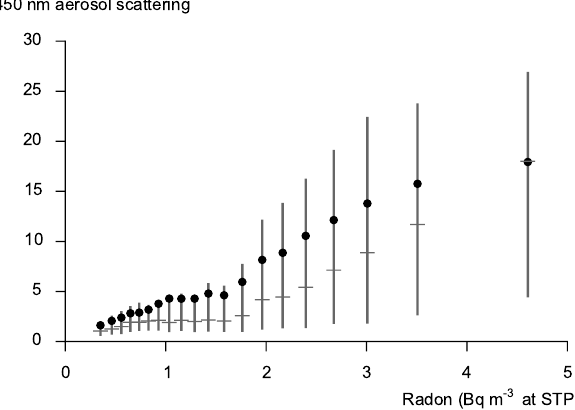
Figure 11. Aerosol scattering coefficient binned by radon concen- tration. Data are from all months and wind directions. The symbols have the same meaning as in Fig.